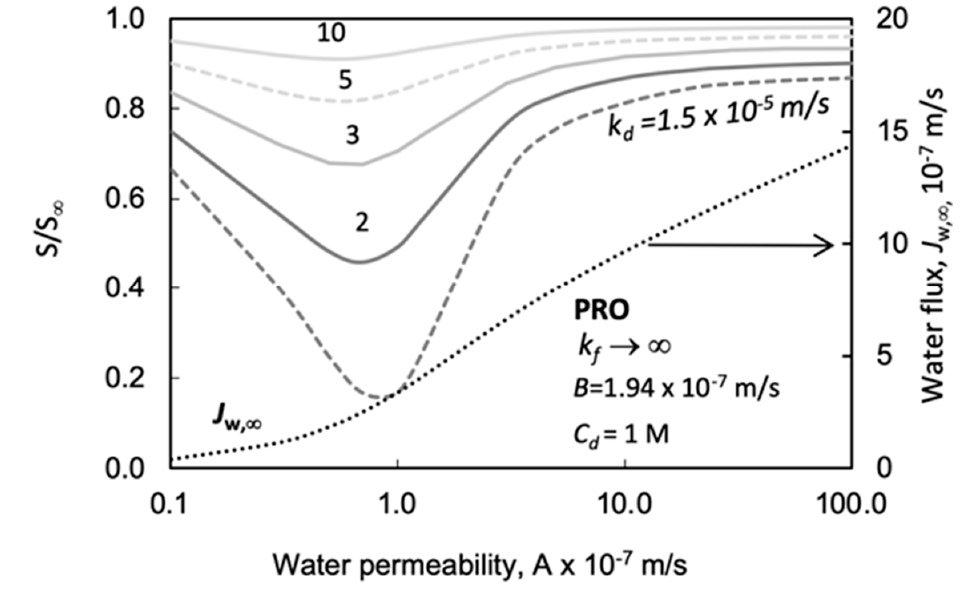
Figure 13. Effect of the water permeability on the value of S/S ∞ and on the water flux, J w , ∞ , as a function of draw side mass transfer coefficient, in a PRO system; C d = 1.0 M; S ∞ = 803 μ m; π d = 43.3 bar; k f → ∞ ; other parameters as they are given in caption of Table 5.